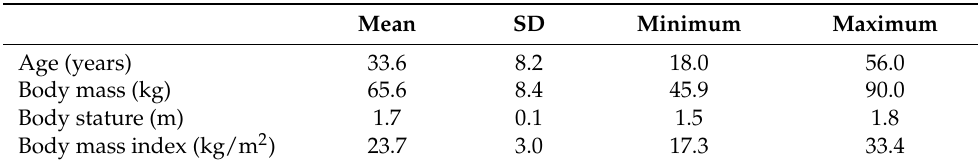
Table A1. Anthropometric characteristics in Study 1.